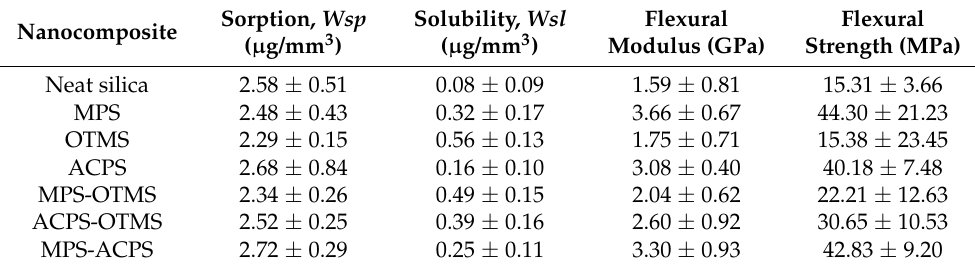
Table 3. Total median values ± interquartile range (IQR) for flexural modulus, flexural strength, and sorption/solubility parameters for dental nanocomposite resins after storage in water at 37 ± 1 ◦ C for 7